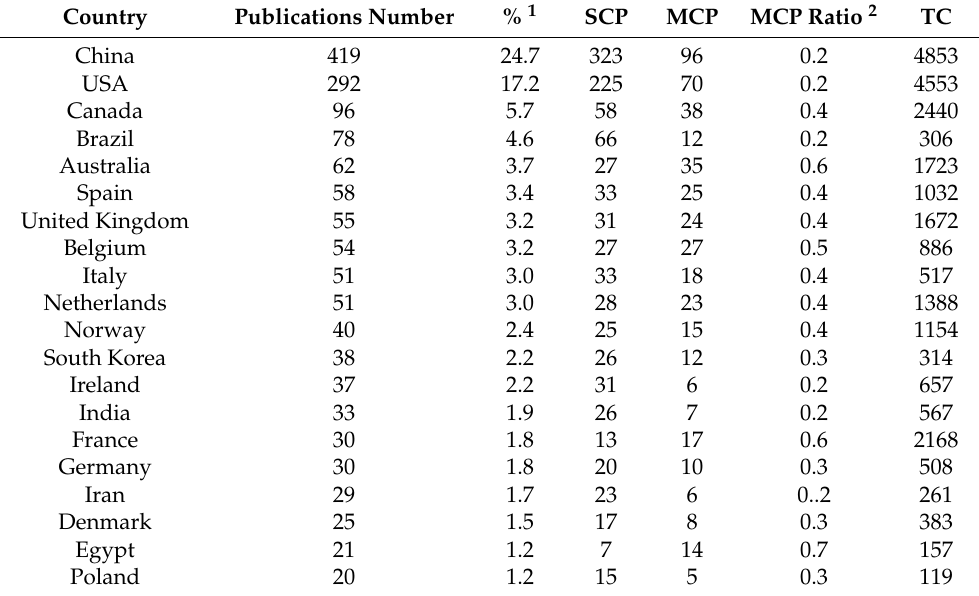
Table 3. Top 20 most prolific countries on veterinary gut health research sorted by publication number.